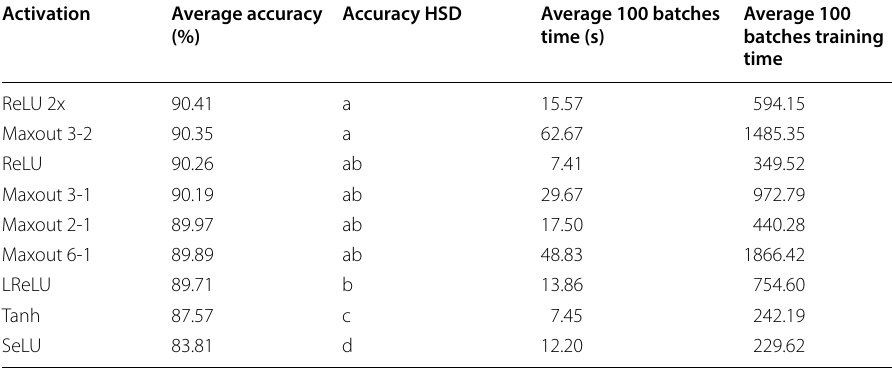
Table 11 Activation HSD test on text datasets Activation Average accuracy